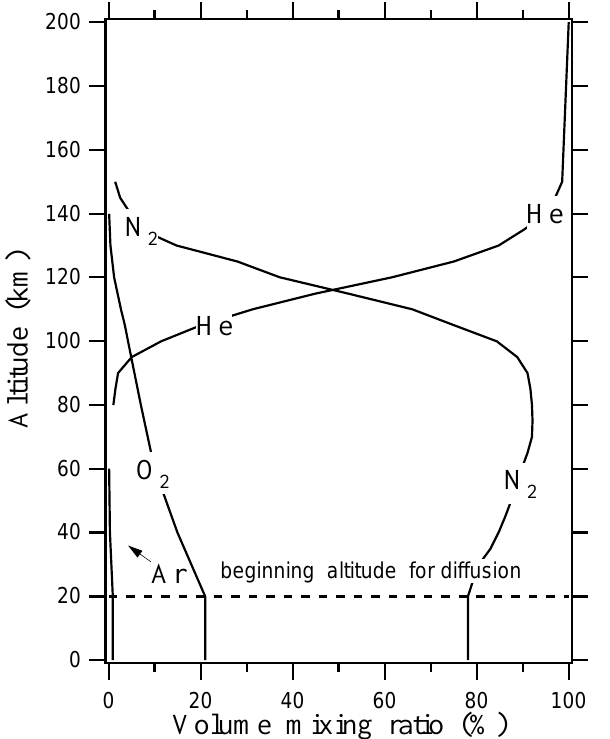
Fig. 1. Vertical distribution of volume mixing ratios computed by Chapman and Milne (1920).